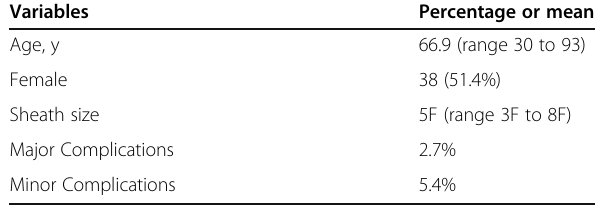
Table 1 Baseline demographics and patientcharacteristics Variables